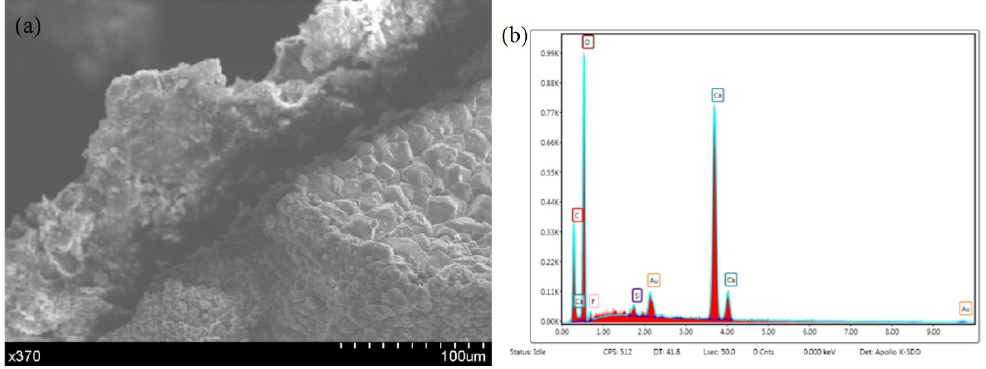
Figure 7. Morphology of the damaged microcapsules in the concrete.